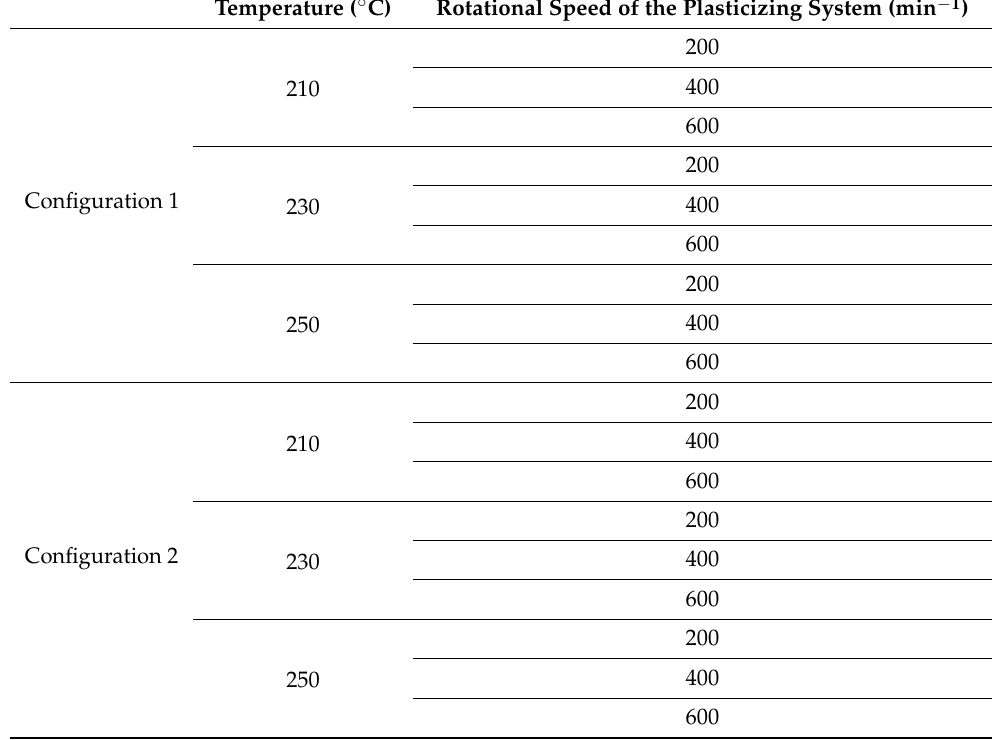
Table 1. Summary of parameters of extrusion processes. Abbreviations: configuration 1—screw with two kneading and mixing zones; configuration 2—screw with four kneading and mixing